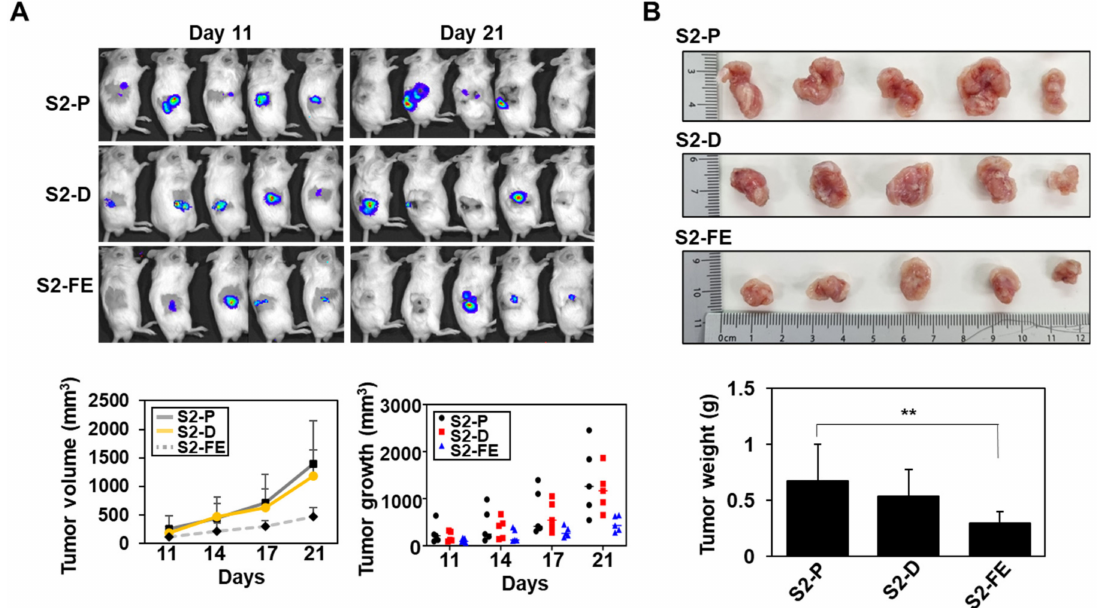
Figure 7. The S2-FE peptide inhibited subcutaneous tumor growth in vivo. ( A ) CT26-luc cells (5 × 10 6 cells/mouse) pre-incubated with peptides (final 250 nM) were subcutaneously injected below the dorsal flank into 6-week-old male BALB/c mice ( n = 5 per group). Representative images of in vivo tumor development at the injection sites are shown. Representative photographs of each primary tumor are shown (top). Average tumor volume (mm 3 ) at 3–4 days post-injection is shown (bottom left). Data are presented as mean ± S.D. ( n = 3). Tumor volume (mm 3 ) at the indicated days post-injection for each individual mouse ( n = 5) are shown (bottom right). ( B ) External caliper measurements were taken (L × W × D) for 21 days, and tumor weight (g) was assessed at the endpoint of the experiment. The columns represent the mean ± S.D. of tumor weight ( n = 5). **, p < 0.01 versus